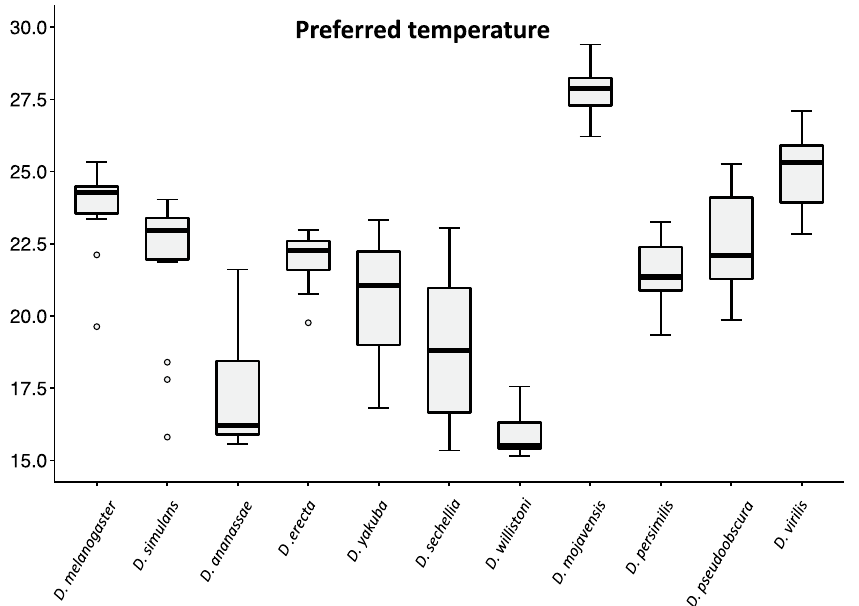
Figure 6. Preferred temperatures of 11 Drosophila species. Preferred temperatures of 11 Drosophila species are shown. Median of the preferred temperature of each species is as follows; D. melanogaster ; 24.3 °C, D. simulans ; 23.0 °C, D. ananassae ; 16.2 °C, D. erecta ; 22.3 °C, D. yakuba ; 21.0 °C, D. sechellia ; 18.8 °C, D. willistoni ; 16.0 °C, D. mojavensis ; 27.9 °C, D. persimilis ; 21.3 °C, D. pseudoobscura ; 21.1 °C, and D. virilis ; 25.3 °C. Circles with box plots show